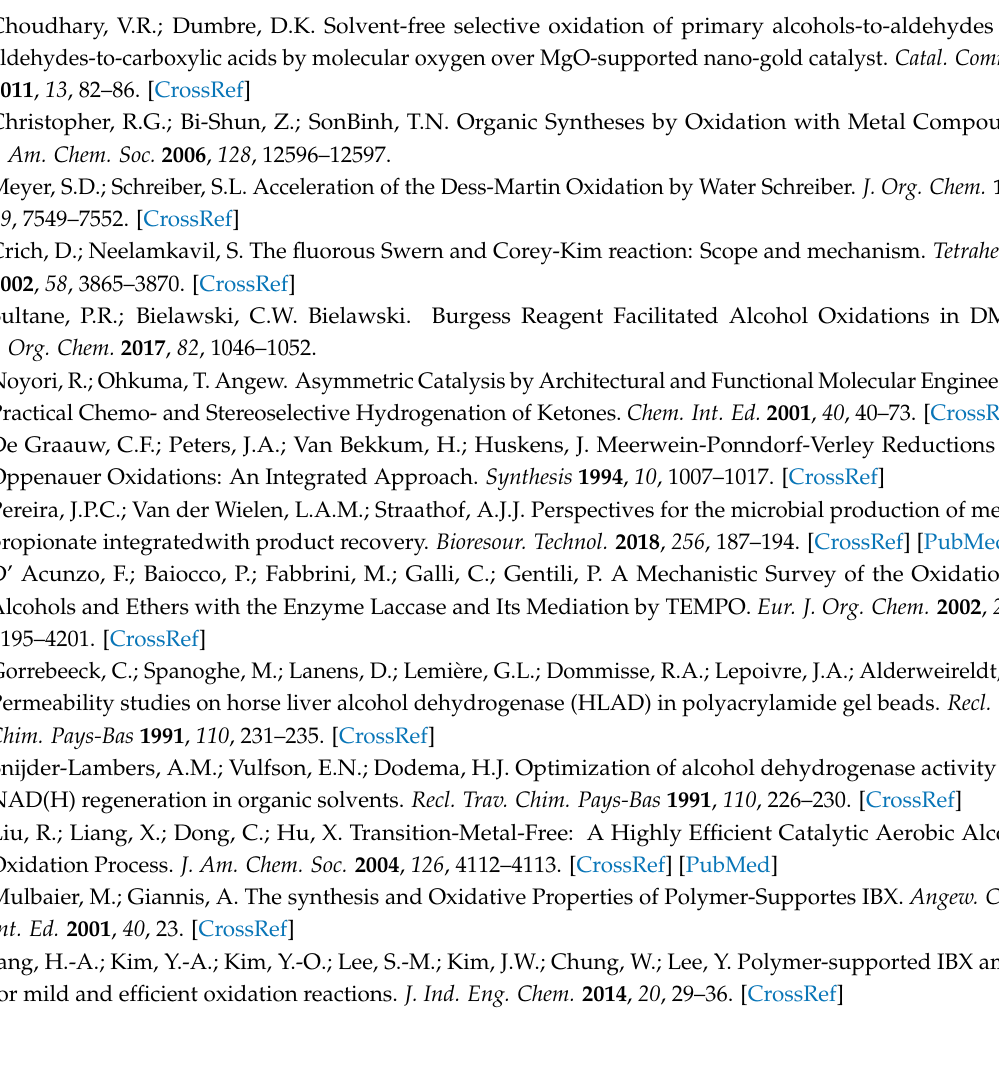
Figure S1: original mass spectra of compounds 9 – 16 ; Figure S2: FTIR analysis of oxMWCNTs I ; Figure S3: FTIR analysis of II A ; Figure S4: FTIR analysis of III A ; Figure S5: FTIR analysis of IV A ; Figure S6: SEM Back Scattered Electrons (BSE) analysis of VIII B